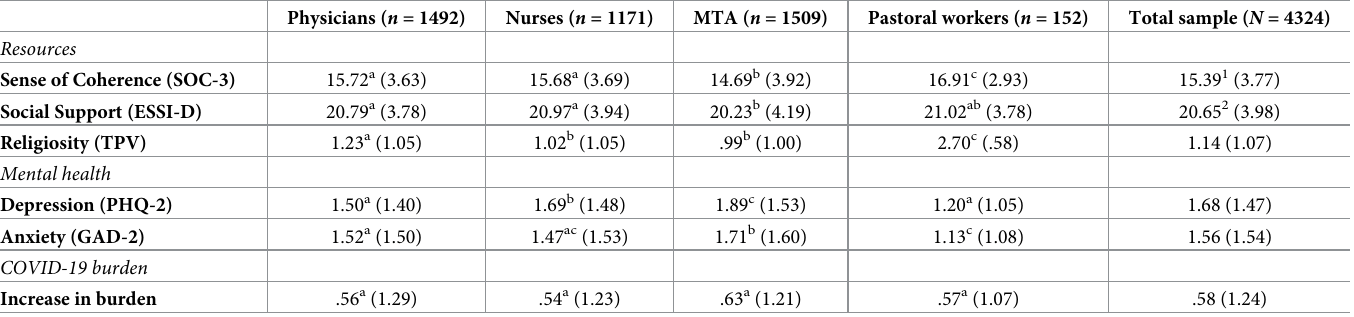
Table 2. Mean scores and standard deviations for resources, mental health and increase in